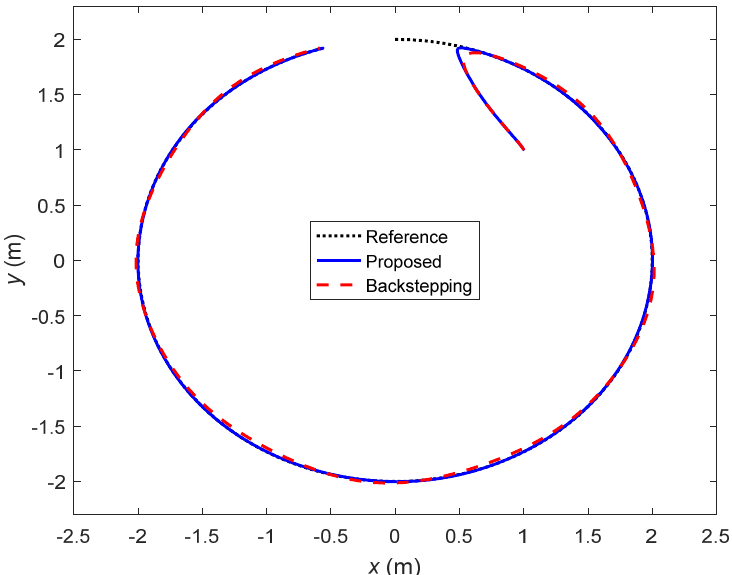
Figure 3. Planar trajectory tracking of the USV (Case 1).